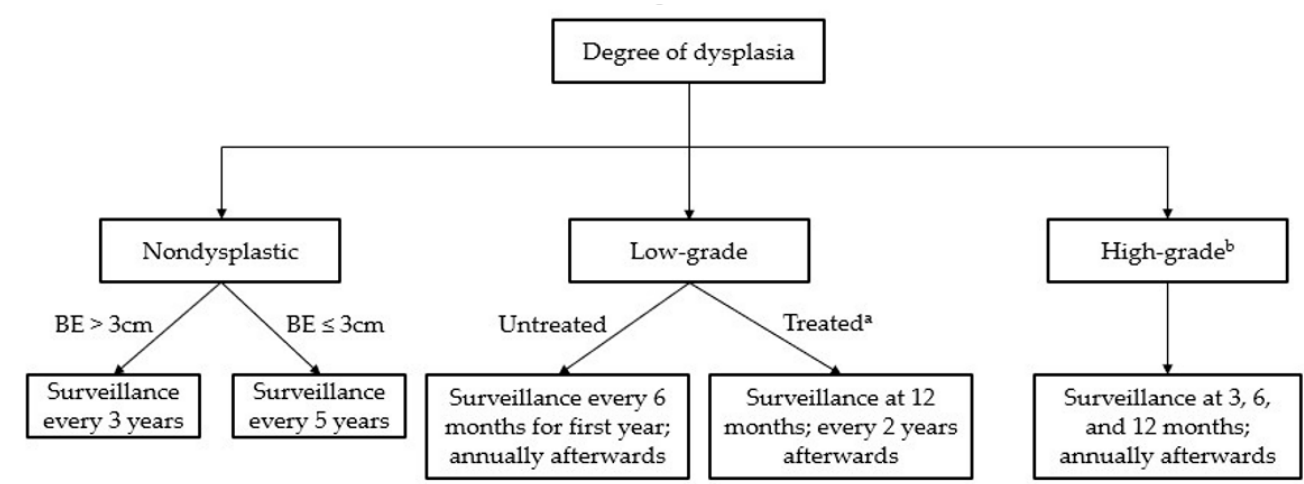
Figure 2. Surveillance guidelines for Barrett’s esophagus. a. “Treated” assumes complete eradica- tion of intestinal metaplasia (CEIM). b. Treatment is recommended in all cases of high-grade dys-